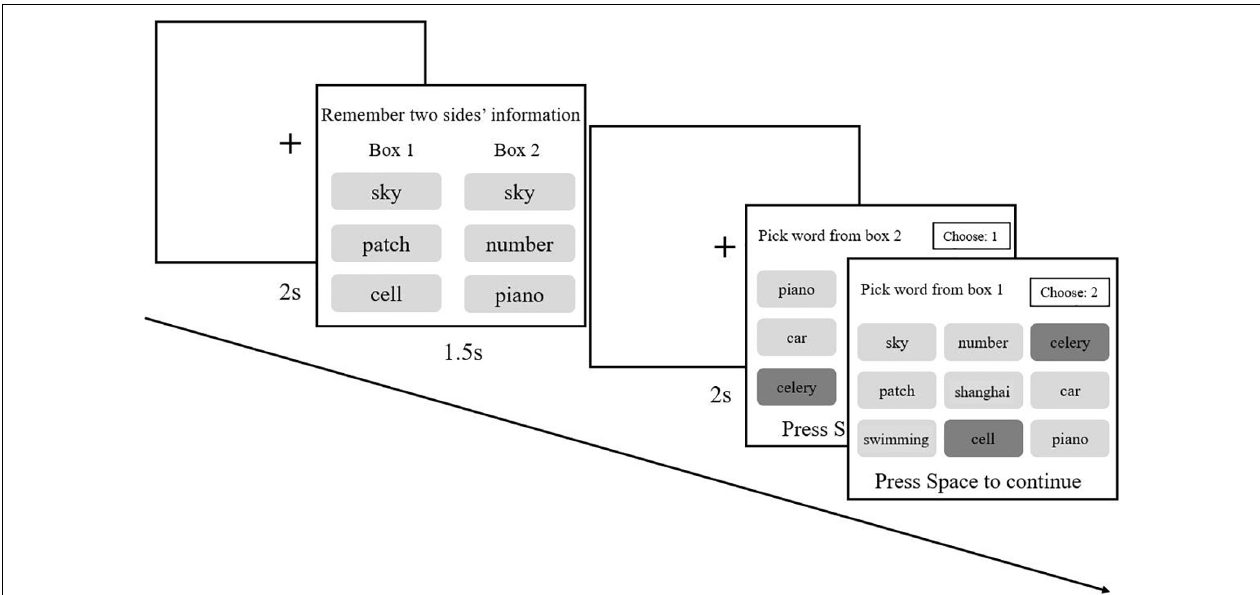
FIGURE 8 | For the first participants of each chain, two groups of three non-repetitive words were randomly chosen and appeared on two sides. In the probe phase, nine words were listed in a 3 × 3 matrix for participants to choose from with a random detecting sequence for two boxes. For example, participants might be told to choose three words they remembered for box 2, and once they had picked three words and pressed the spacebar to confirm, another probe phase of the box 1 appeared. In the probe phase of each trial, the presented nine words would be randomized. For subsequent participants, three words from both boxes recognized by the previous participants would be presented randomly.